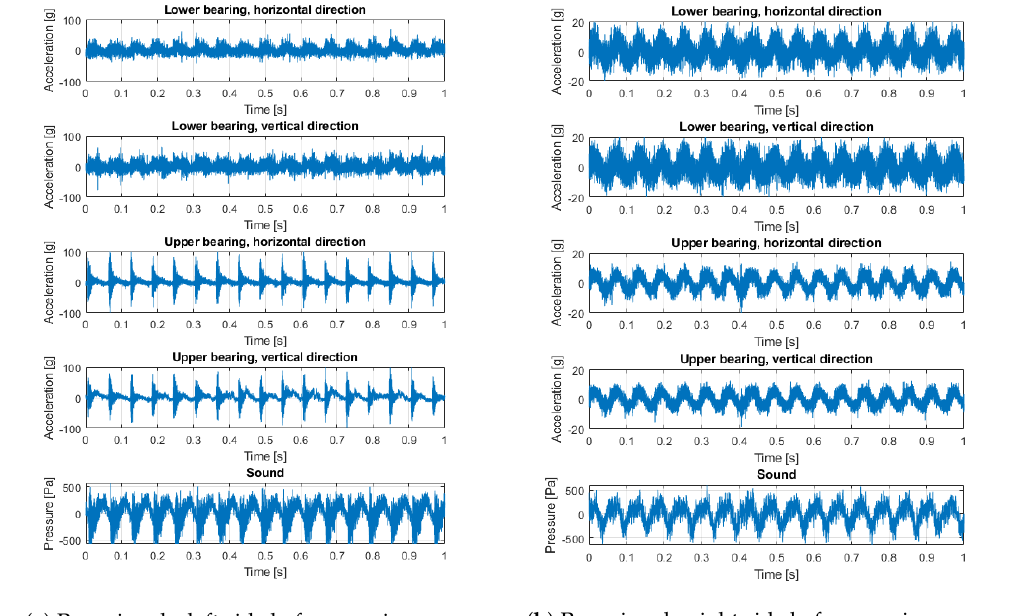
Figure 6. Raw signals : left and right side before repair.